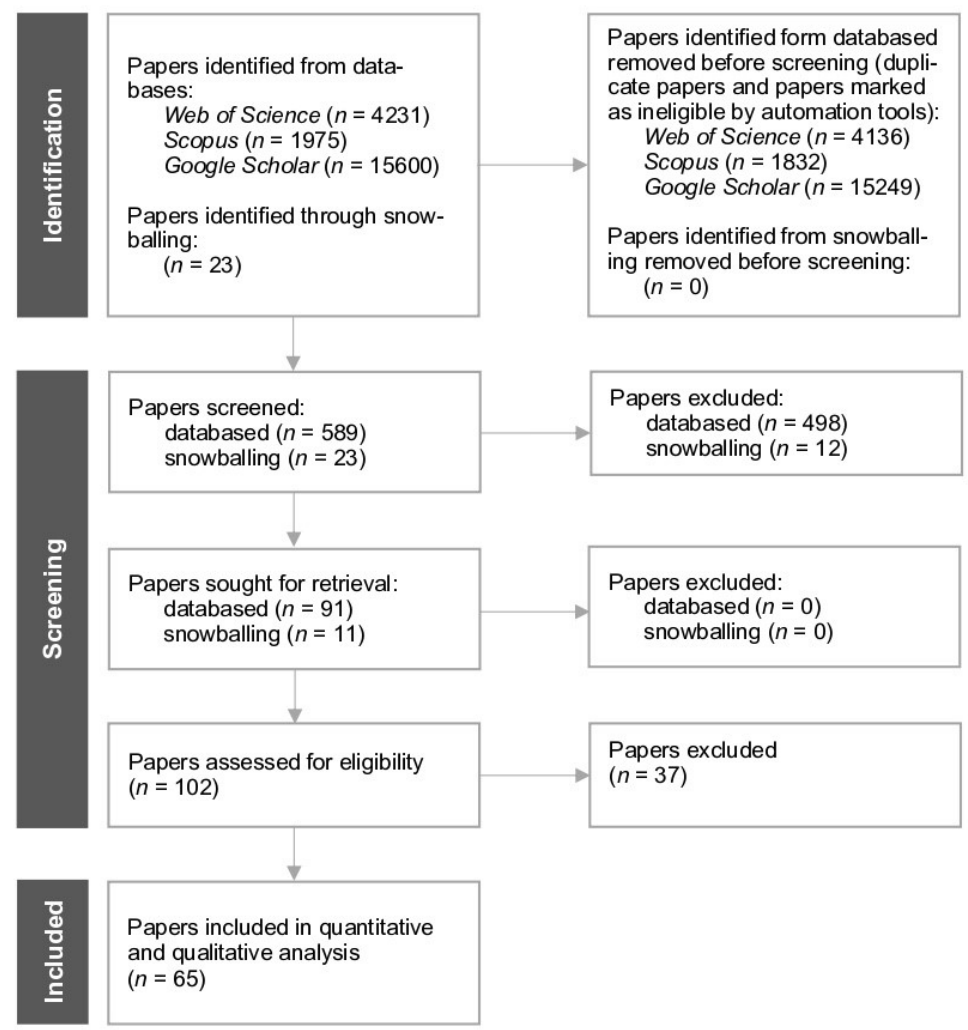
Figure 1. PRISMA flow diagram of literature review.